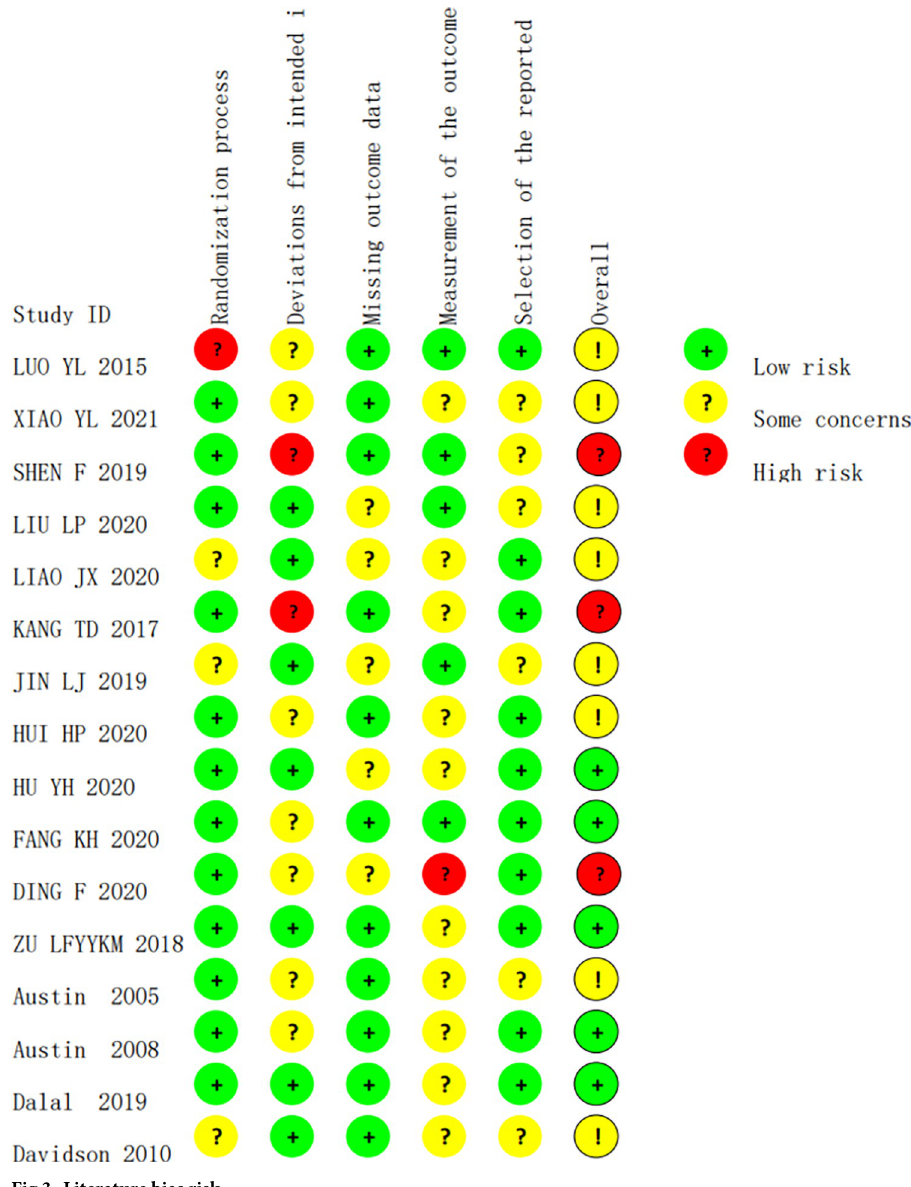
Fig 3. Literature bias